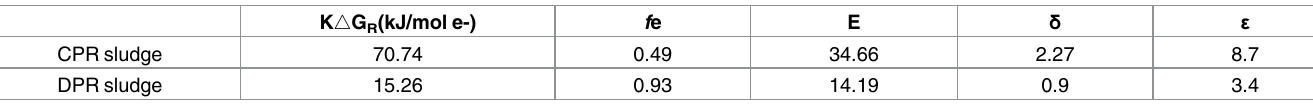
Table 3. Energy consumed by CPR and DPR sludges in the synthesis